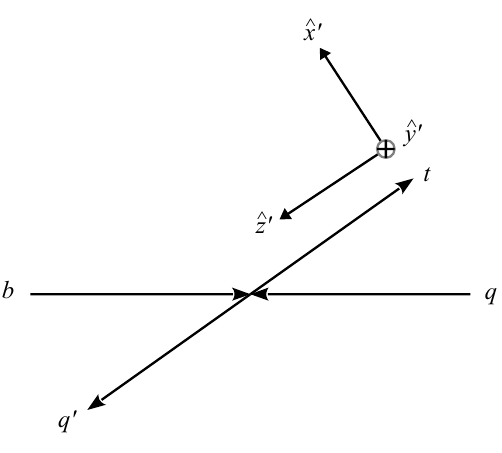
Figure 2 . Diagram illustrating the three orthogonal directions ˆ x 0 , ˆ y 0 and ˆ z 0 used in this analysis, as seen in the zero-momentum frame of the initial-state quarks. The ˆ z 0 direction is that of the spectator quark in the top-quark rest frame. The ˆ x 0 direction lies in the production plane, while the ˆ y 0 direction is perpendicular to the production